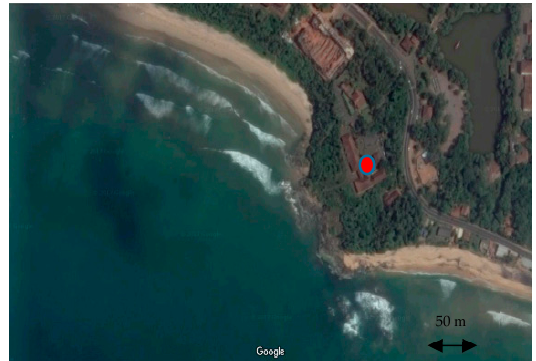
Figure 1. A satellite view of the measuring station (red dot) located in a few tens of meters from the sea. Adapted from Google maps (10/ 9/ 2017). Imagery ©2017 DigilatGlobe, Map data ©2017 Google.